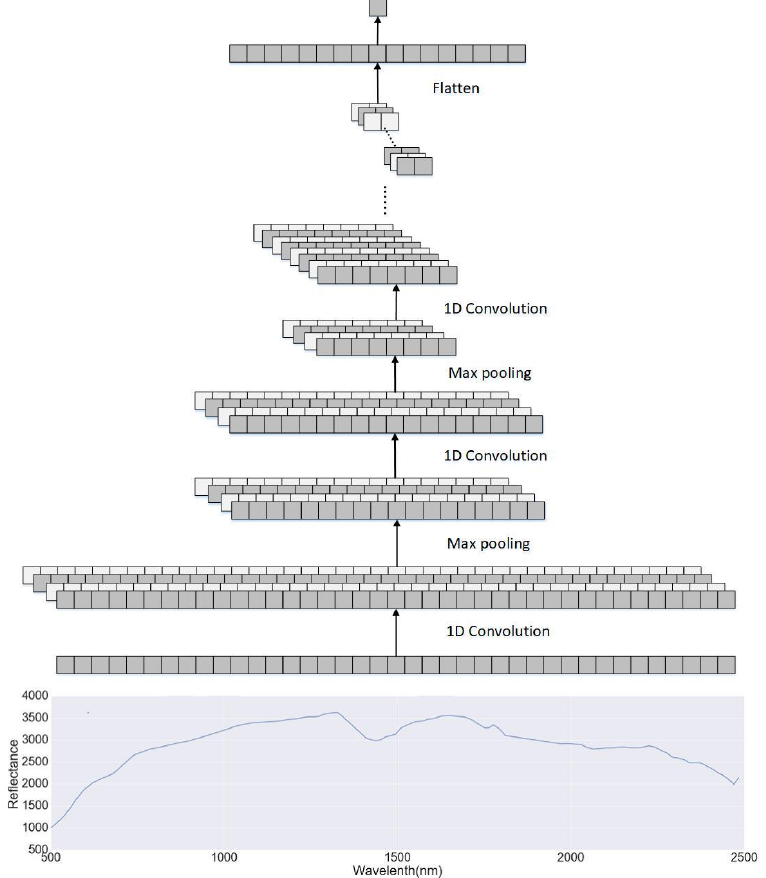
Figure 4. The architecture of the convolutional neural network (CNN) for soil property